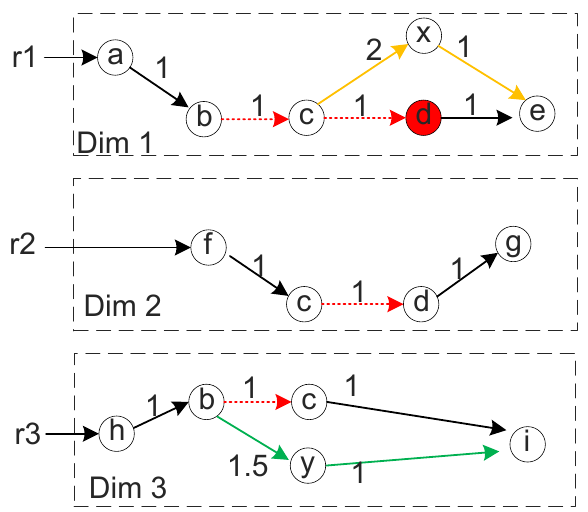
Figure 3. Counterexample of the inclusion property of soft-collision M* (SC-M*) in the soft-collision context. Agents r 1, r 2, and r 3 have the planning O-D demands ( a , e ) , ( f , g ) , and ( h , i ) , respectively. Vertexes in the system are labeled as a , b , c ,